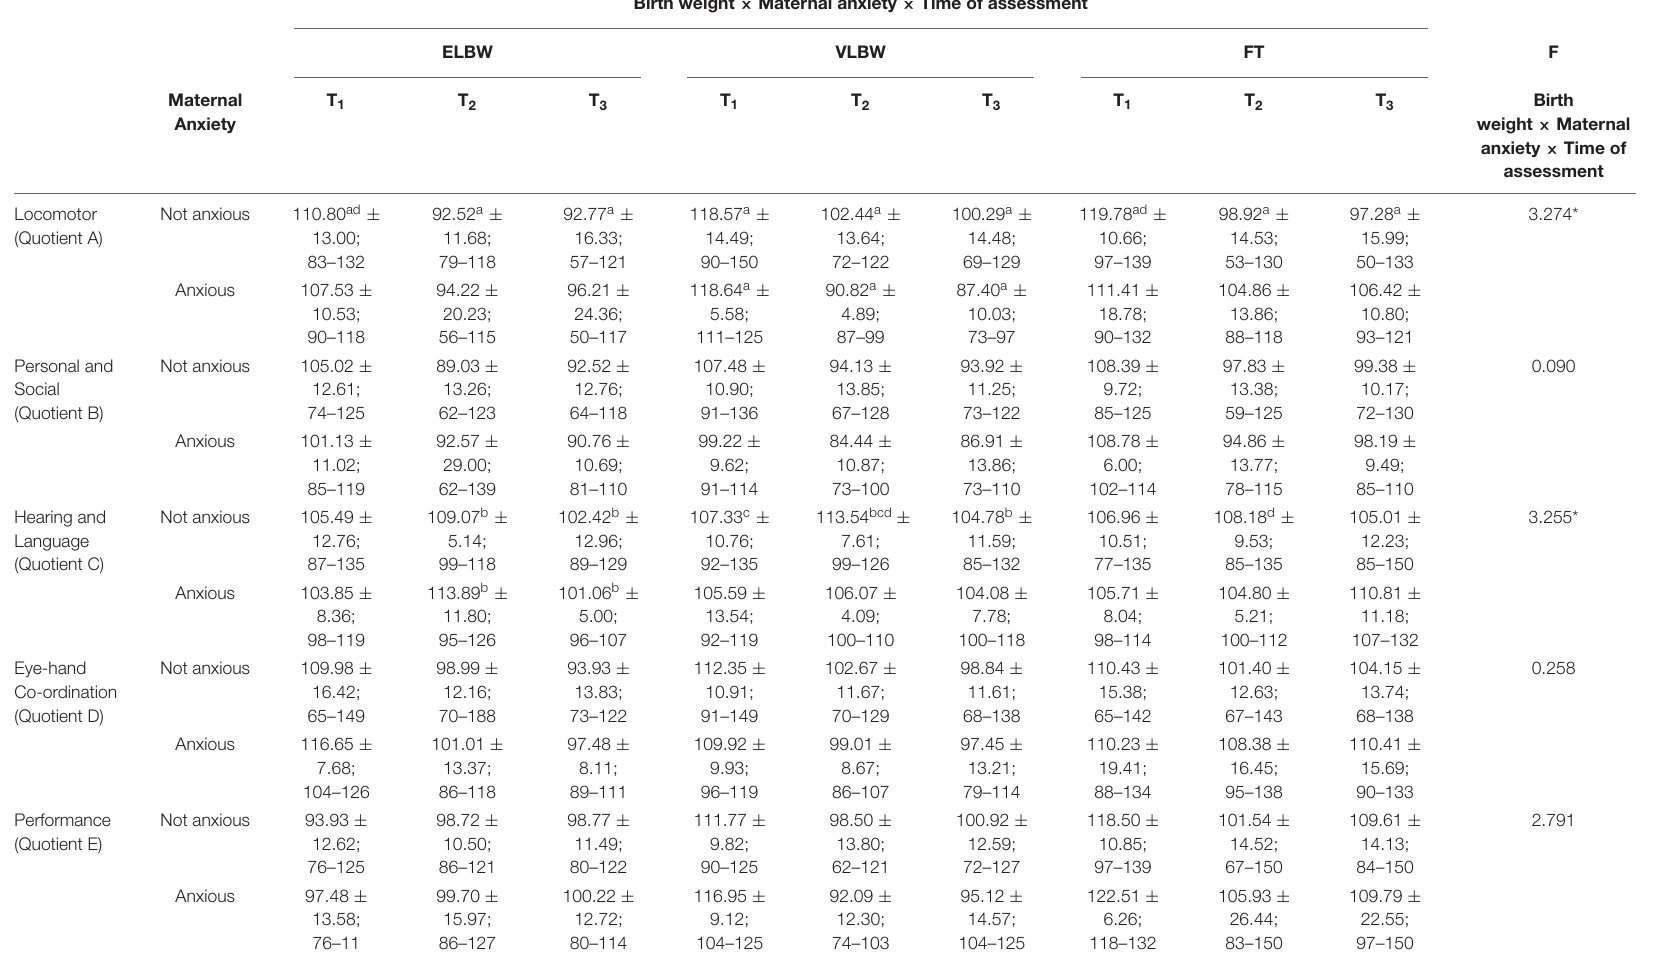
TABLE 4 | Griffiths Mental Development Scales infants’ quotients according to the interaction between birth weight. Birth weight × Maternal anxiety × Time of